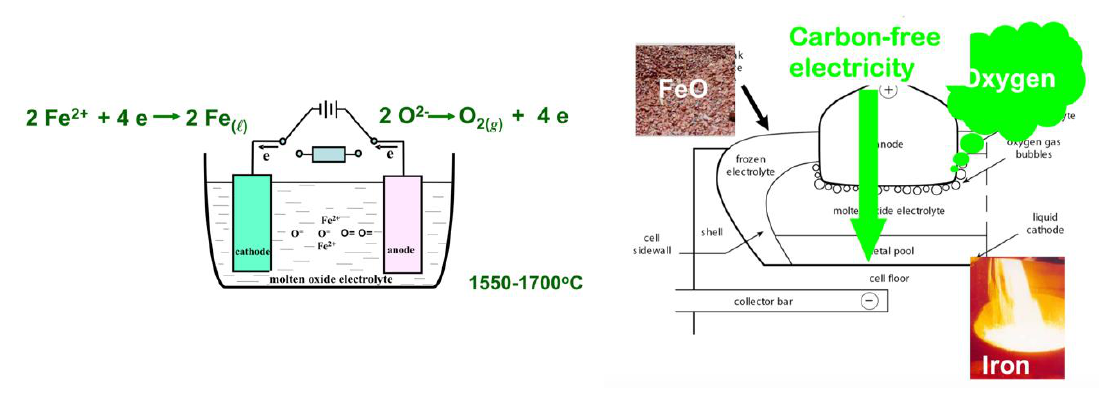
Figure 24. The MOE process of D. Sadoway.